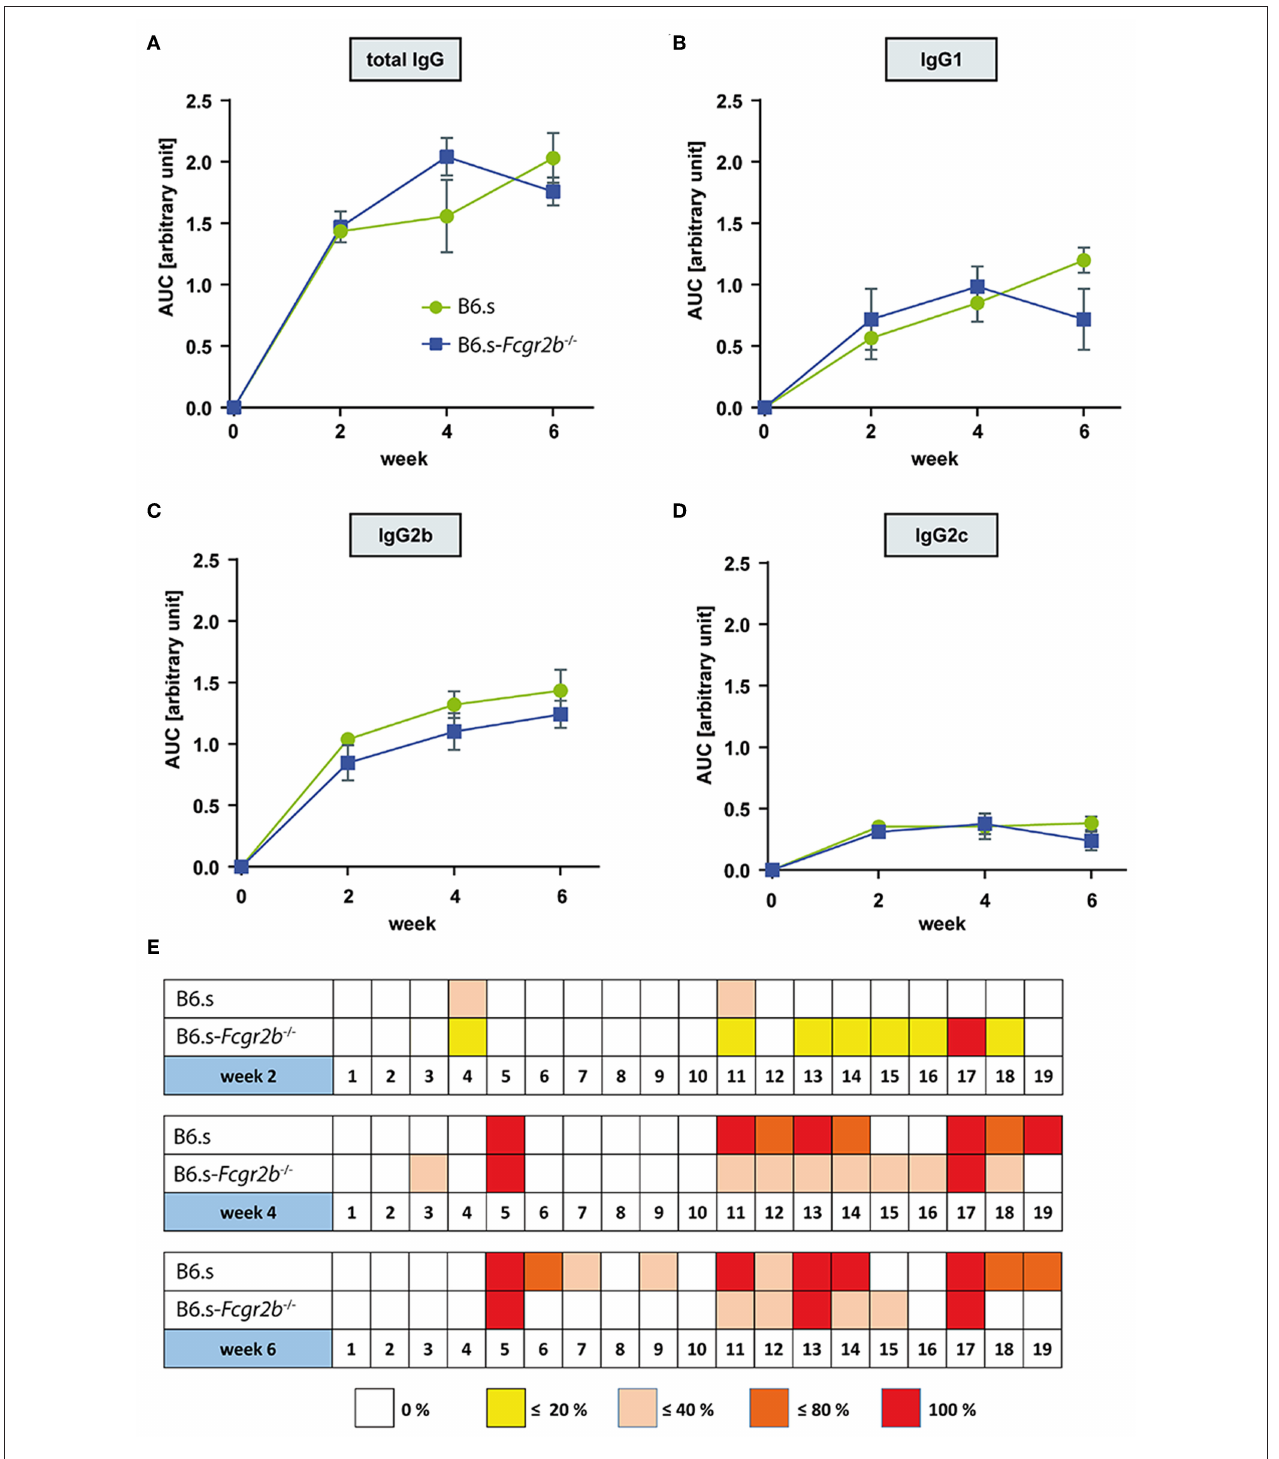
FIGURE 2 | Comparison of vWFA2-specific serum IgG levels and epitope mapping during the first 6 weeks after vWFA2 immunization. Course of vWFA2-specific (A) total IgG, (B) IgG1, (C) IgG2b; and (D) IgG2c serum aAb levels. The IgG serum levels between B6.s wt and B6.s- Fcgr2b − / − mice were similar. n = 4/group and time point. (E) Linear epitope mapping of vWFA2-specific total IgG using 20 amino acids long polypeptides of vWFA2 with an overlap of 10 amino acids. IgG peptide binding was determined via ELISA. n ≥ 3/group and time point. The depicted frequencies (0, < 20, < 40, < 80, and 100%) relate to the percent of sera in B6.s wt or B6.s- Fcgr2b − / − mice that reacted with respective